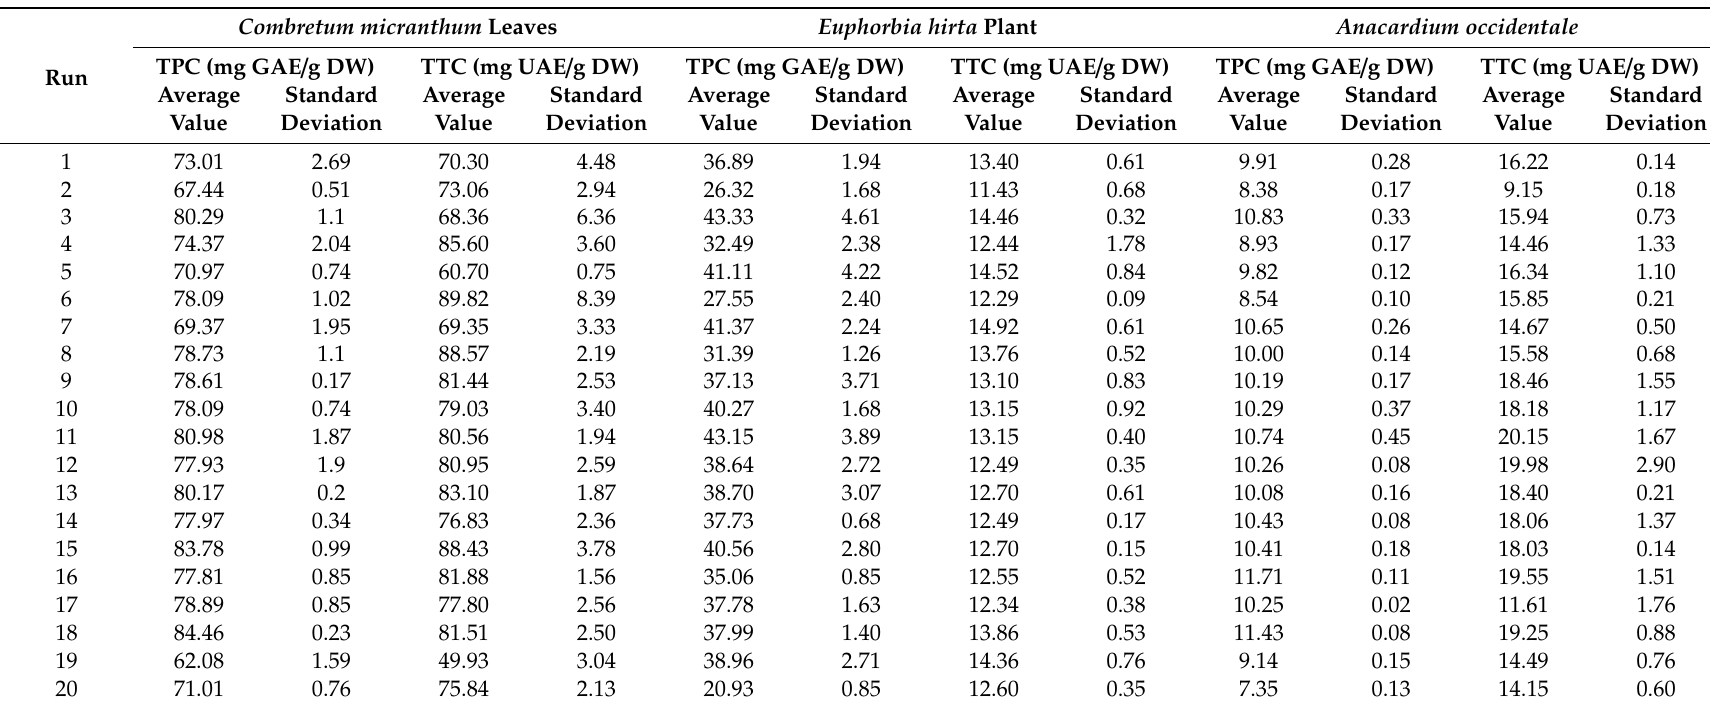
Table 1. Experimental data for the responses obtained from C. micrathum leaves, E. hirta plant and A. occidentale